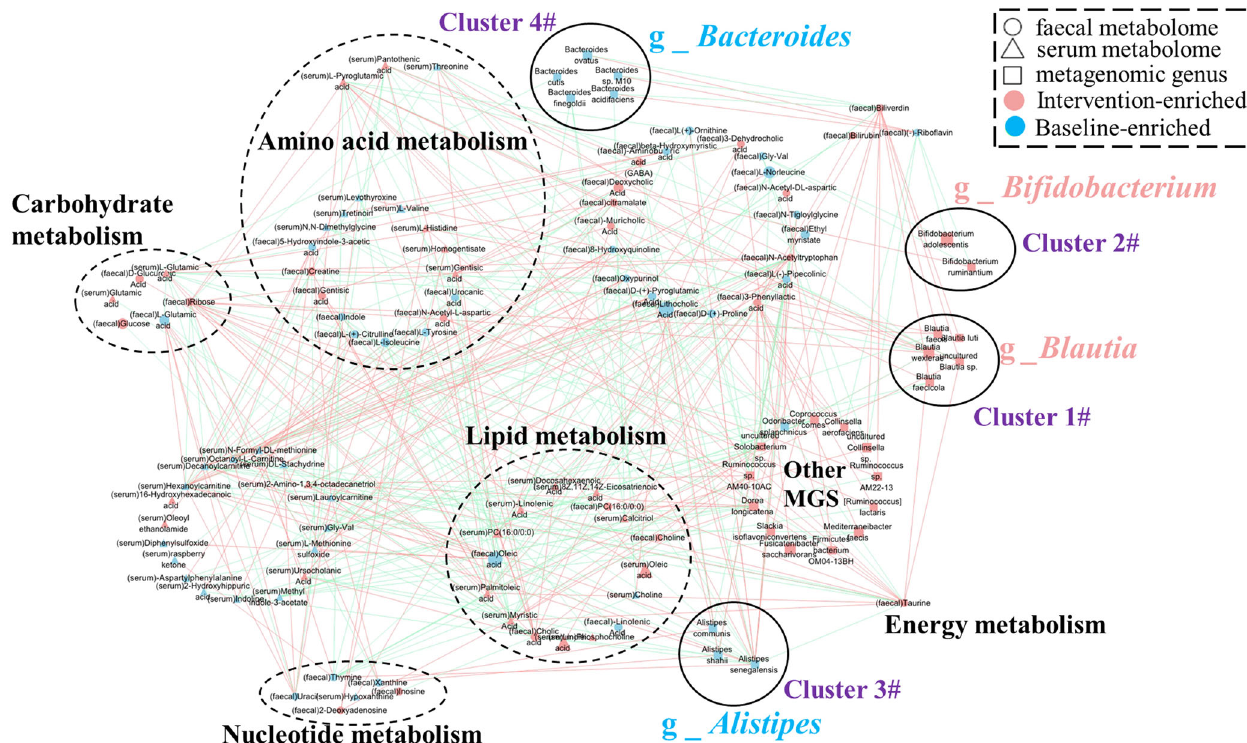
Fig. 6 Co-occurrence network constructed based on the relative abundance of differential MGS, fecal metabolites, and serum metabolites of workers administered with probiotic yogurt. The differential MGS primarily generated four covarying units (clusters 1 – 4). The size of the nodes represents the abundance of these variables. Red and blue dots, respectively, indicate the increase and decrease of relative abundances of variables after the probiotic yogurt intervention compared with the baseline values. The edges between nodes indicate Spearman ’ s positive (red) or negative (blue) correlation; the edge thickness indicates the range of p values ( p < 0.05). Source data and exact p values are provided in the source data fi